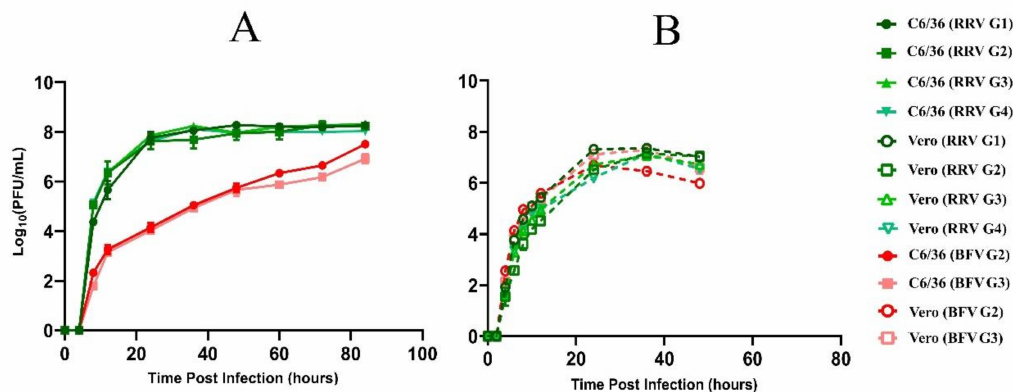
Figure 5. Replication kinetics of representative Ross River virus (RRV, green) and Barmah Forest virus variants (BFV, red) in C6 / 36 and Vero cell lines, over time. ( A ) Comparison of viral production (Log 10 PFU / mL) of representatives of RRV genotypes 1–4 (G1–4) and representatives of BFV genotype 2 and 3 (G2–3) in C6 / 36 cells over time. ( B ) Comparison of viral production (Log 10 PFU / mL) of RRV G1–4 and BFV G2–3 in Vero cells over time. Bars present the standard error of the mean between two independent infection